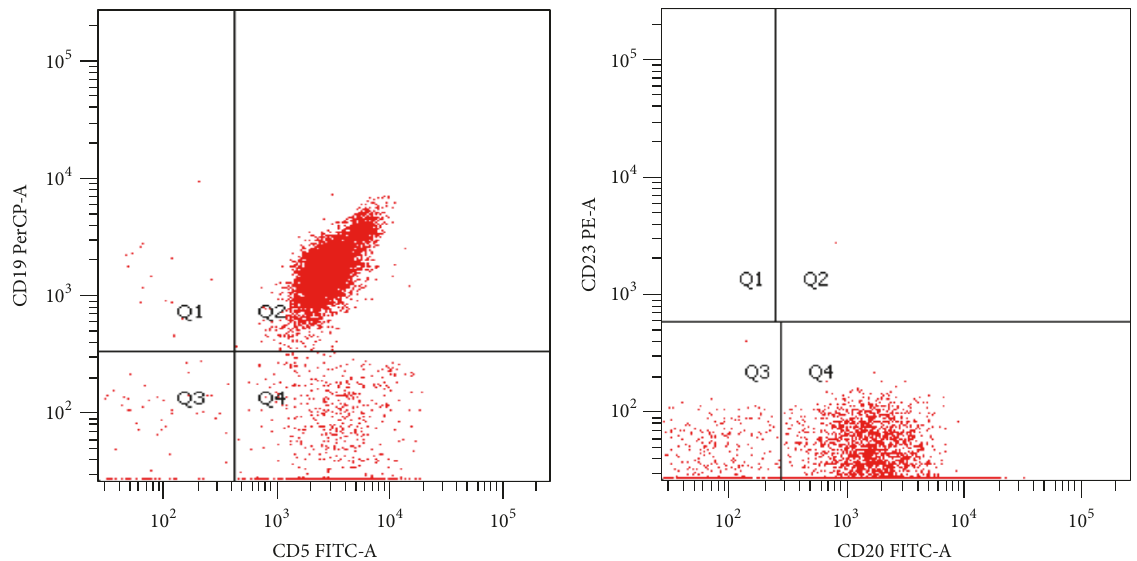
Figure 1: Flow cytometry on CSF reveals a positive expression of CD19, CD20, and CD5 and negativity of CD23.